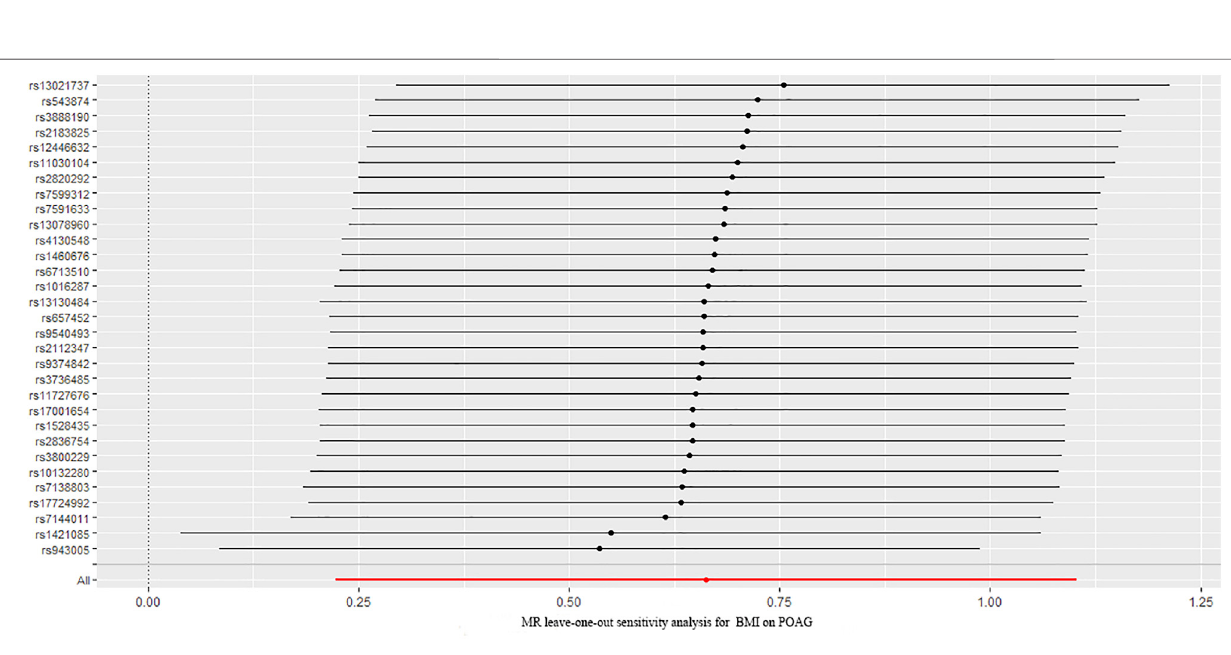
Frontiers in Genetics |